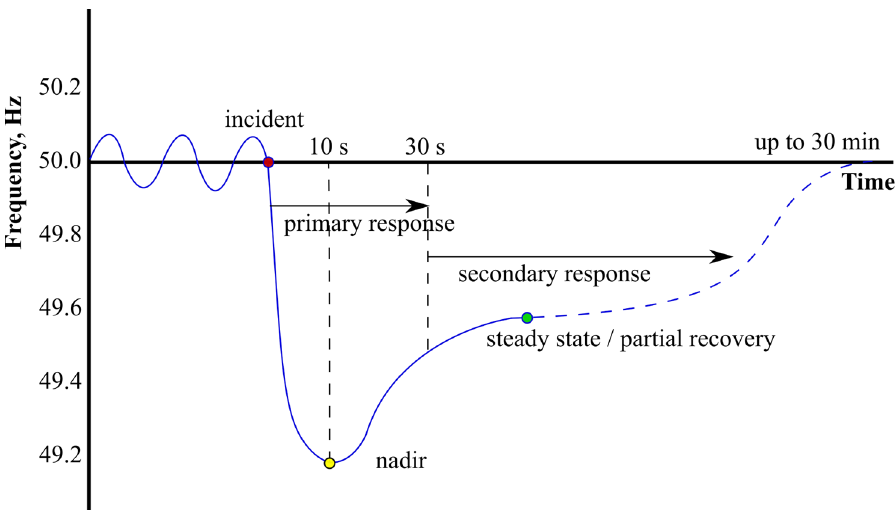
Figure 1. Overview of Firm Frequency Response (National Grid).